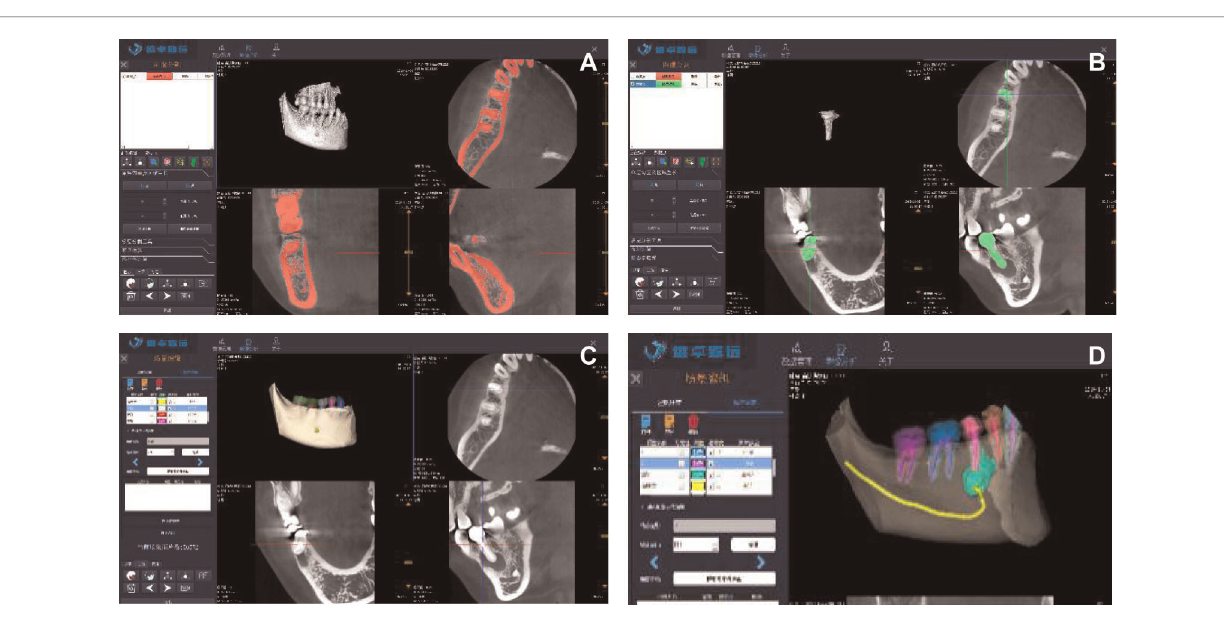
FIGURE 2 | The 3D model of the patient. ( A ) Rending the target area ( B ) Obtaining the mandible and the affected tooth ( C ) Obtaining the lesion area ( D ) De fi ning the surface color of the V3D model.